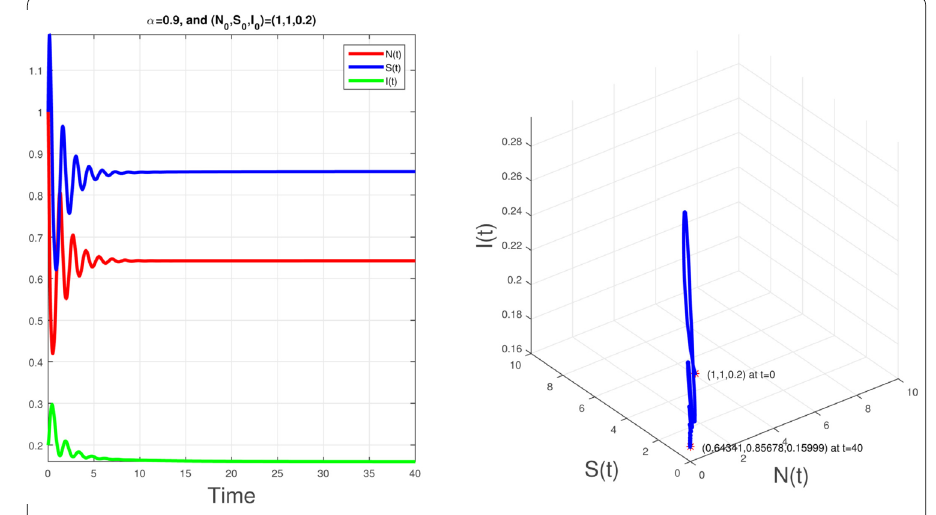
Figure 8 Local stability of the DFE